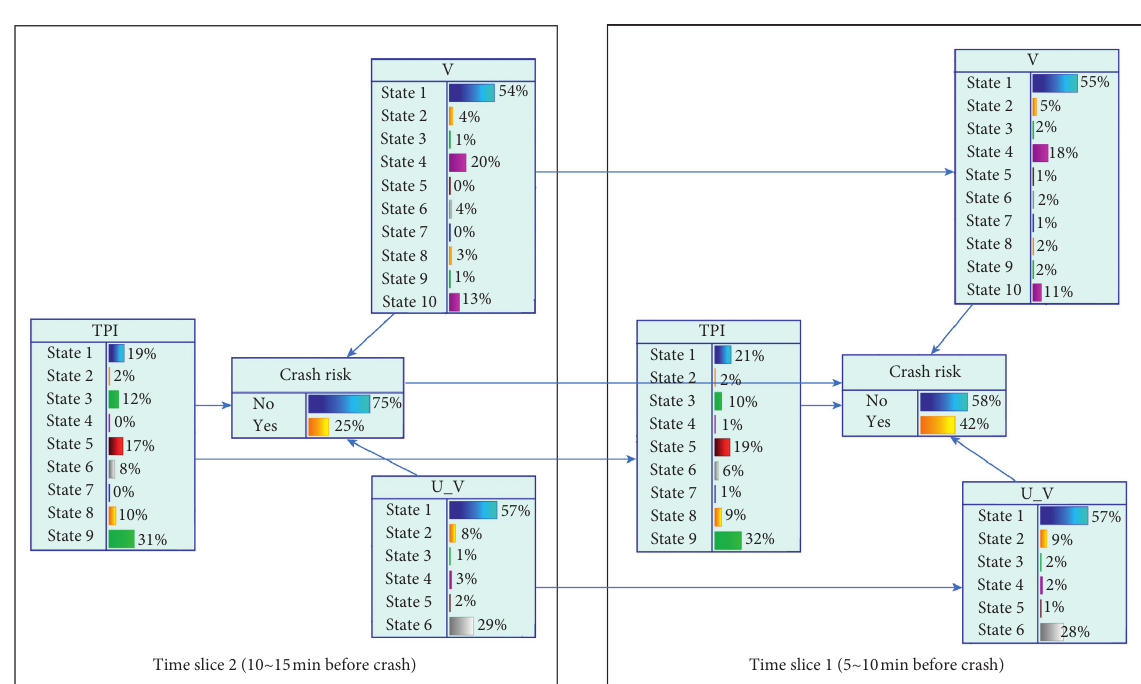
Figure 9: Initial state of the original DBN-based